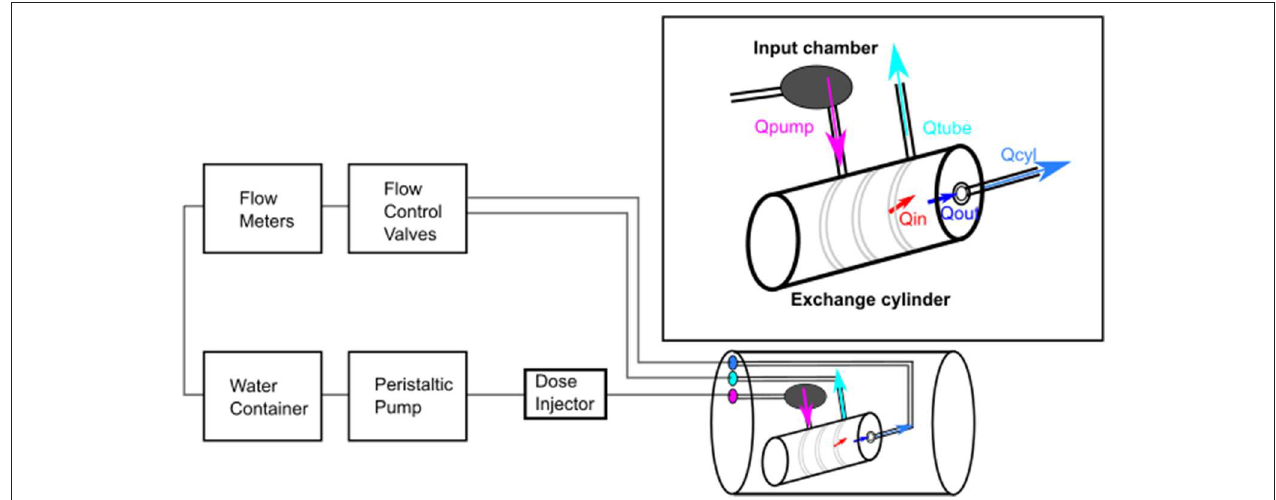
FIGURE 1 | Flow phantom set-up. The peristaltic pump creates the flow inside the phantom with a constant flow rate Qpump. The phantom shell includes an input chamber and an exchange cylinder, where both the image-derived input function and tissue activity curves can be defined by region-of-interest analysis. A perforated tube is located inside the exchange cylinder, where the tracer passes from the tube to the cylinder. The flow inside the perforated tube is Qtube and inside the exchange cylinder Qcyl which are controlled with flow control valves. Qin and Qout are the modeled image-derived flow values. Qin represents flow from the perforated tube to the exchange cylinder and Qout flow out from the exchange cylinder [ 16].